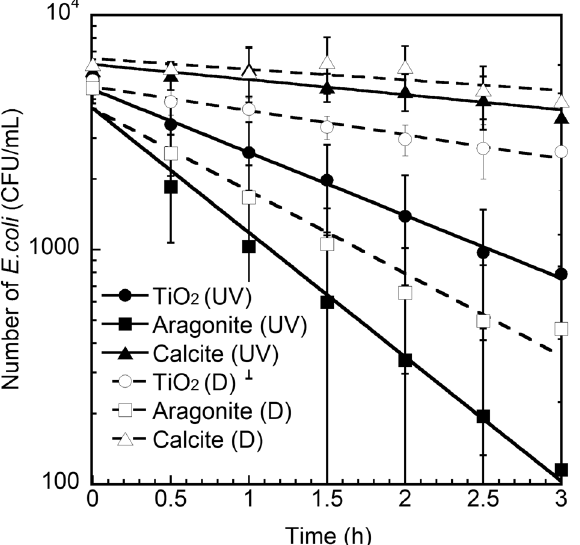
Figure 8. Change in the number of E. coli cells over time in circulation systems featuring unmodified, calcite- modified and agonite-modified TiO 2 ceramics under dark (D) and UV light (UV)